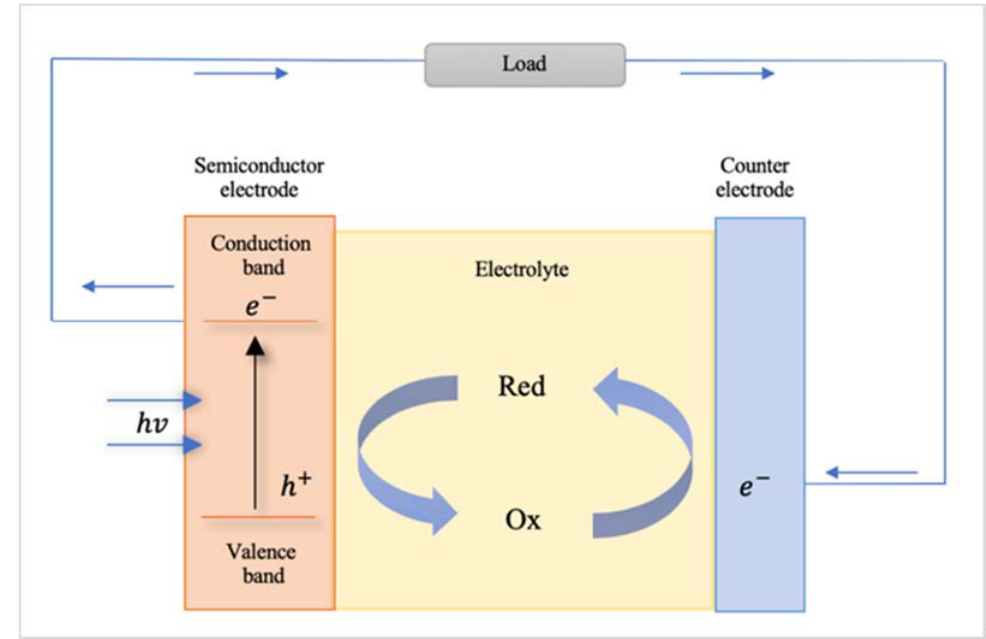
Materials 2021 , 14 , x FOR PEER REVIEW